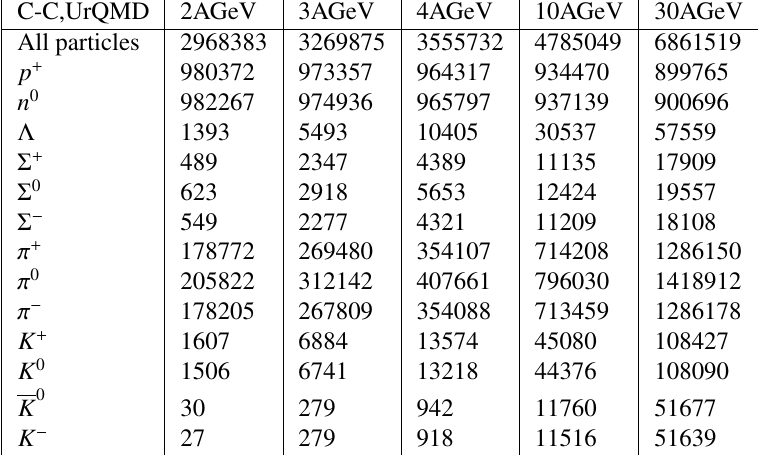
Table 1. Total amount of produced particles for 10 5 C-C interaction at di ff erent energies from